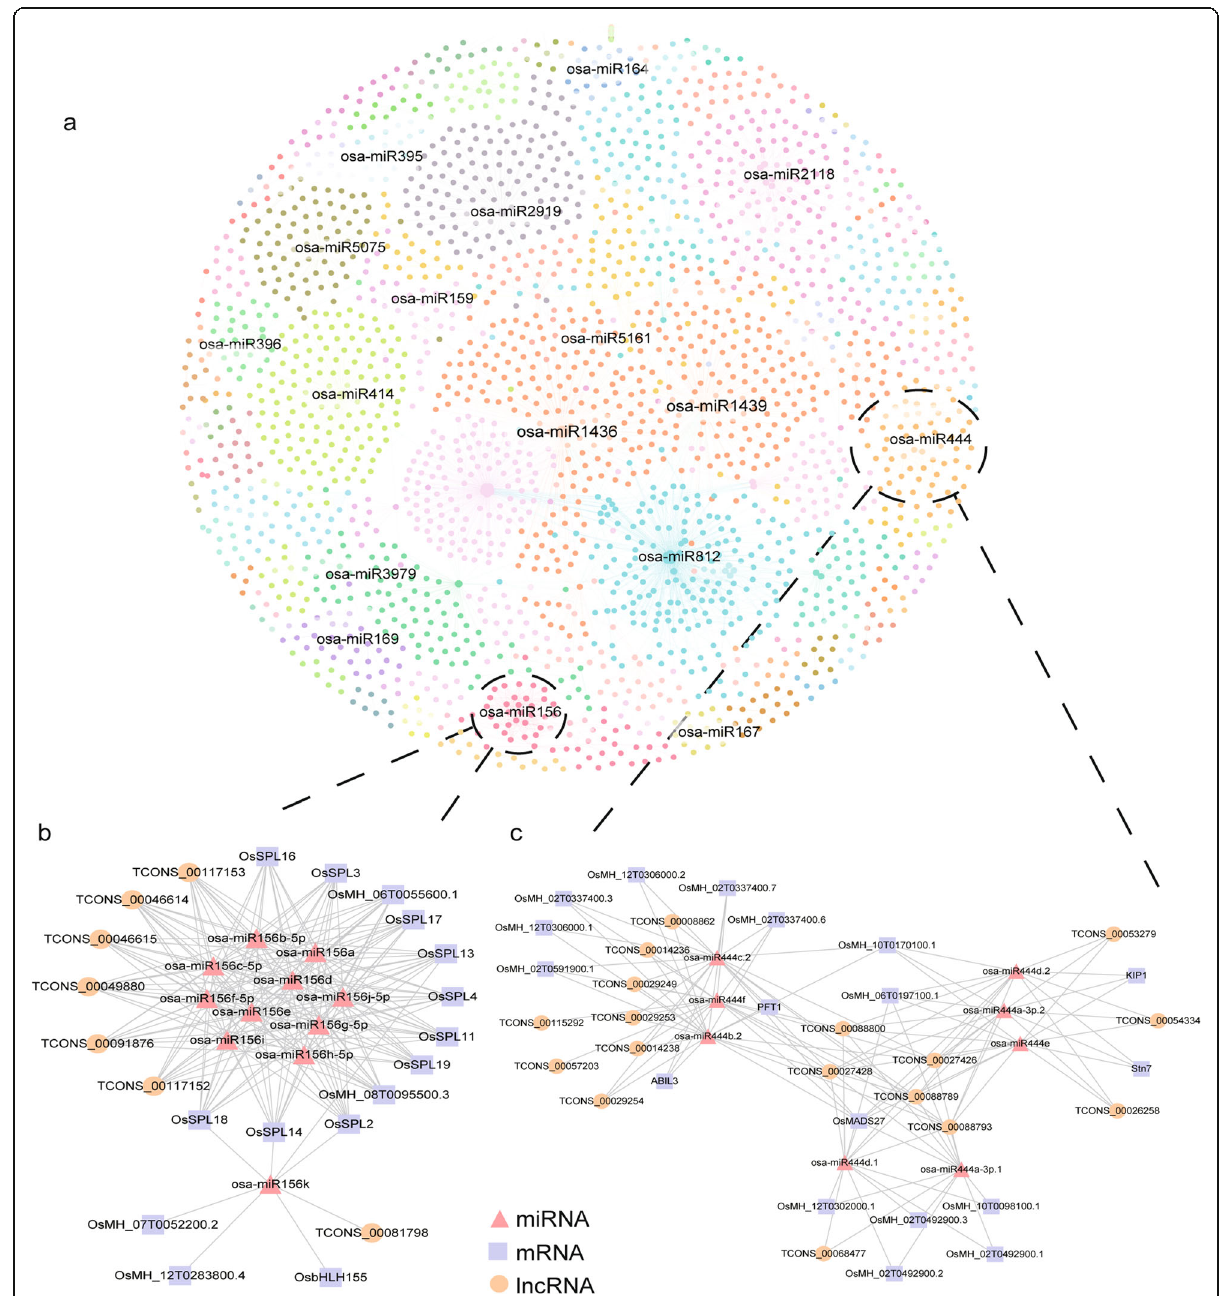
Fig. 5 ceRNA network in MH63. a ceRNA network in which each color represents the different interactions of a miRNA. b osa-miR156 and ( c ) osa- miR444 miRNA families (red) ceRNA networks with lncRNAs (orange) and mRNAs